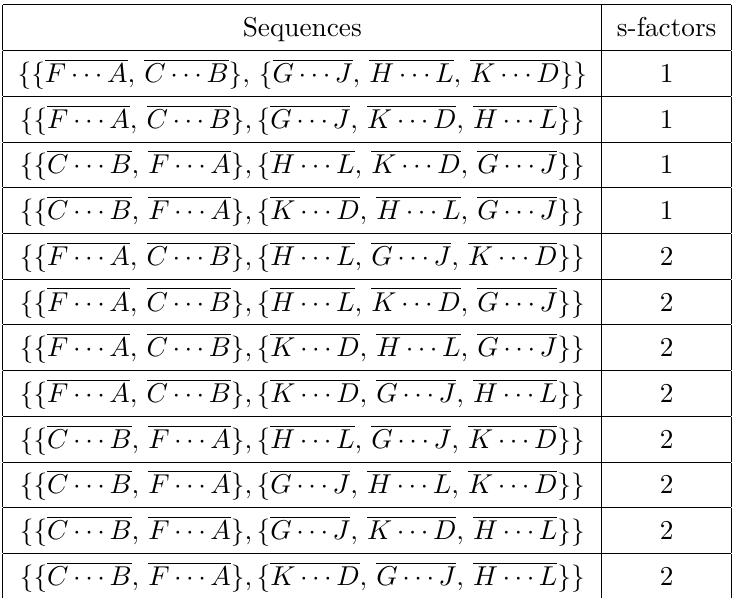
Figure 13. Diagram of the general Cweb W (1 , 1 , 1 , 1)